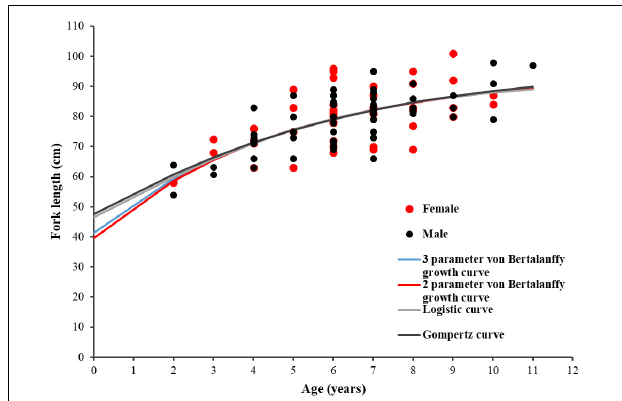
FIGURE 8 | Length-at-age plot for P. kamoharai showing fittings of the four growth models for combined sexes. Red dots represent female specimens; Black dots represent male specimens. The blue line represents the fitting curve of the 3-parameter von Bertalanffy model; the red line represents the fitting curve of the 2-parameter von Bertalanffy model; the gray line represents the fitting curve of the logistic model, and the black line represents the fitting curve of the Gompertz model.